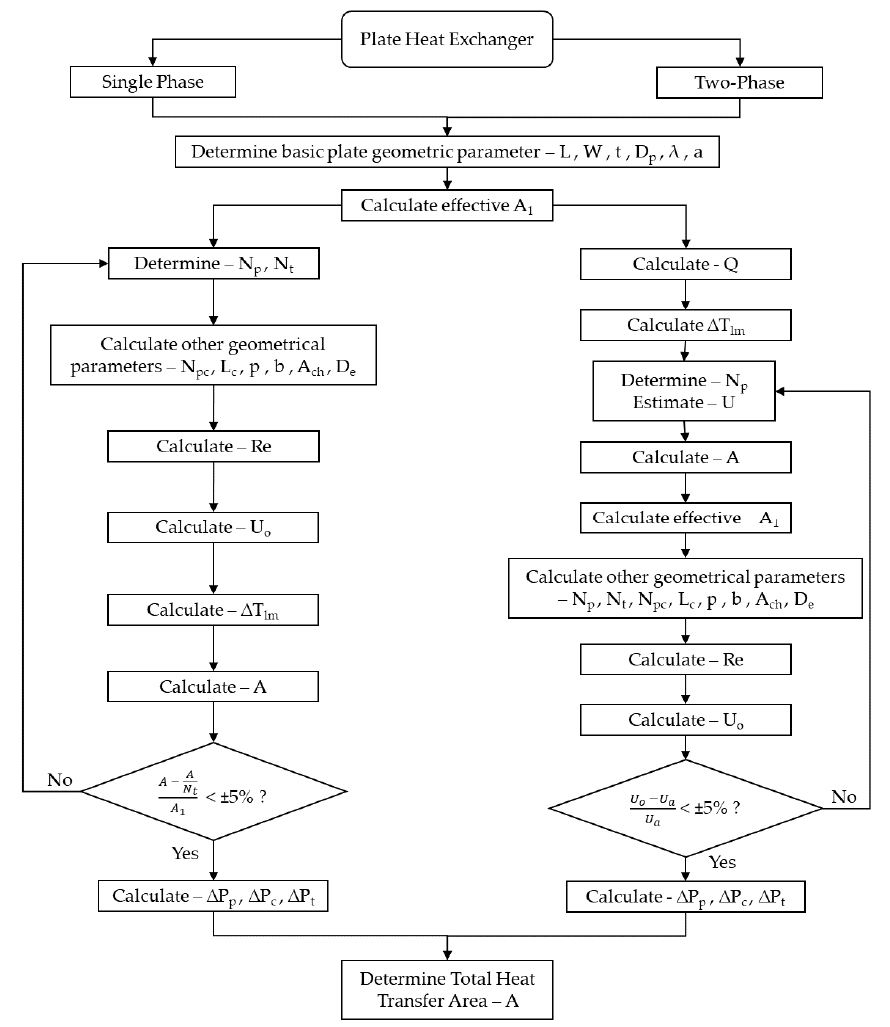
Figure 4. Design method flow chart for Plate Heat Exchanger (PHX) sizing for the single phase and two-phase options.